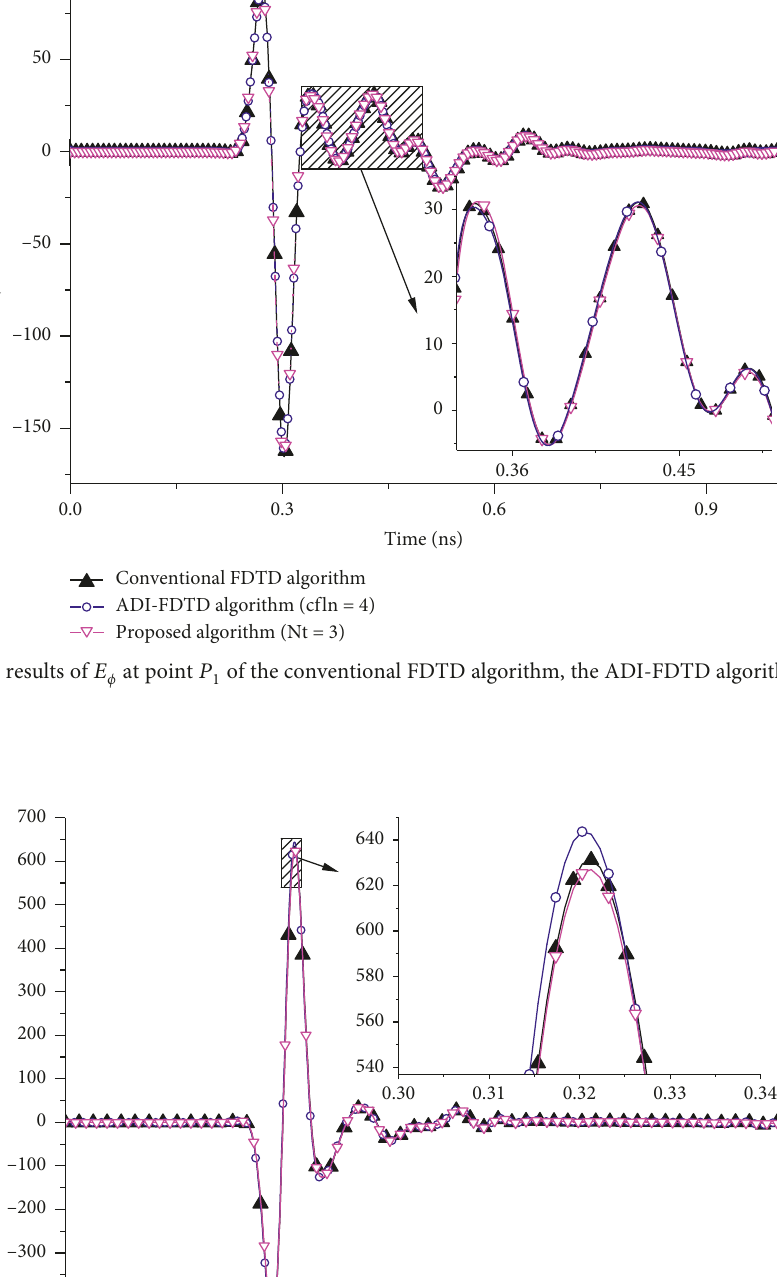
P 2 of the conventional FDTD algorithm, the ADI-FDTD algorithm [5], and the proposed